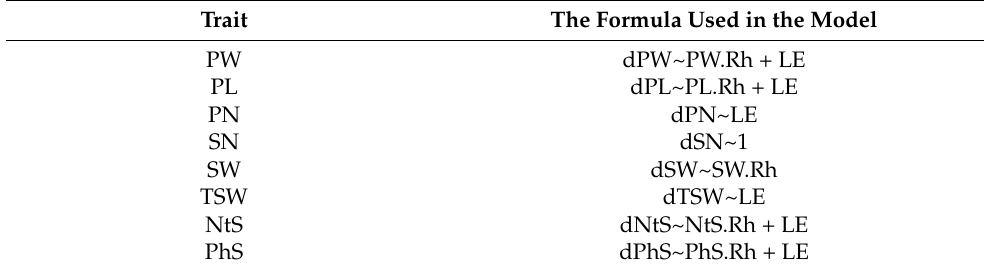
Table 7. The models chosen for regression analysis of AM-caused increments in traits. Trait The Formula Used in the Model